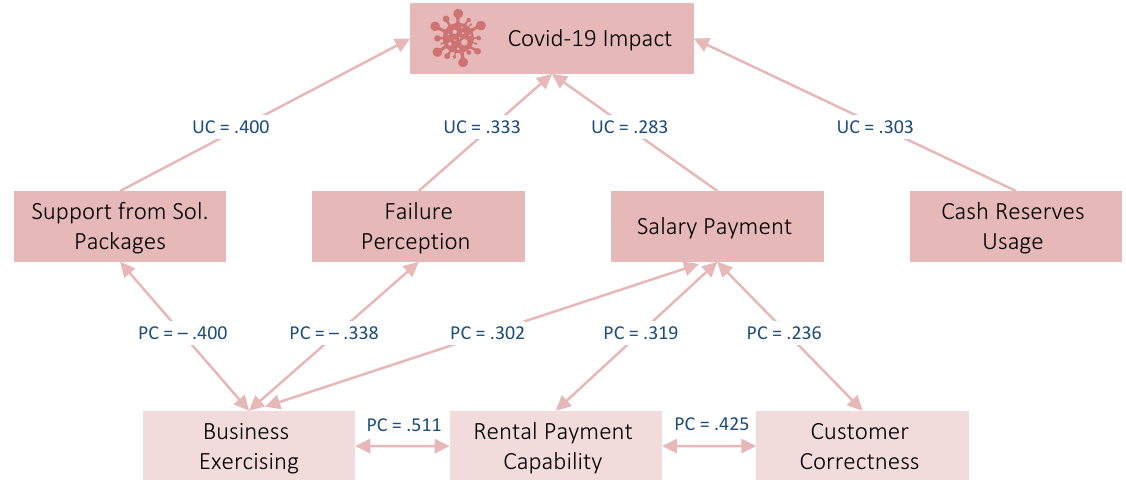
Figure 7. Impact of Covid-19 from the point of view of Econometric and Statistical Relationships